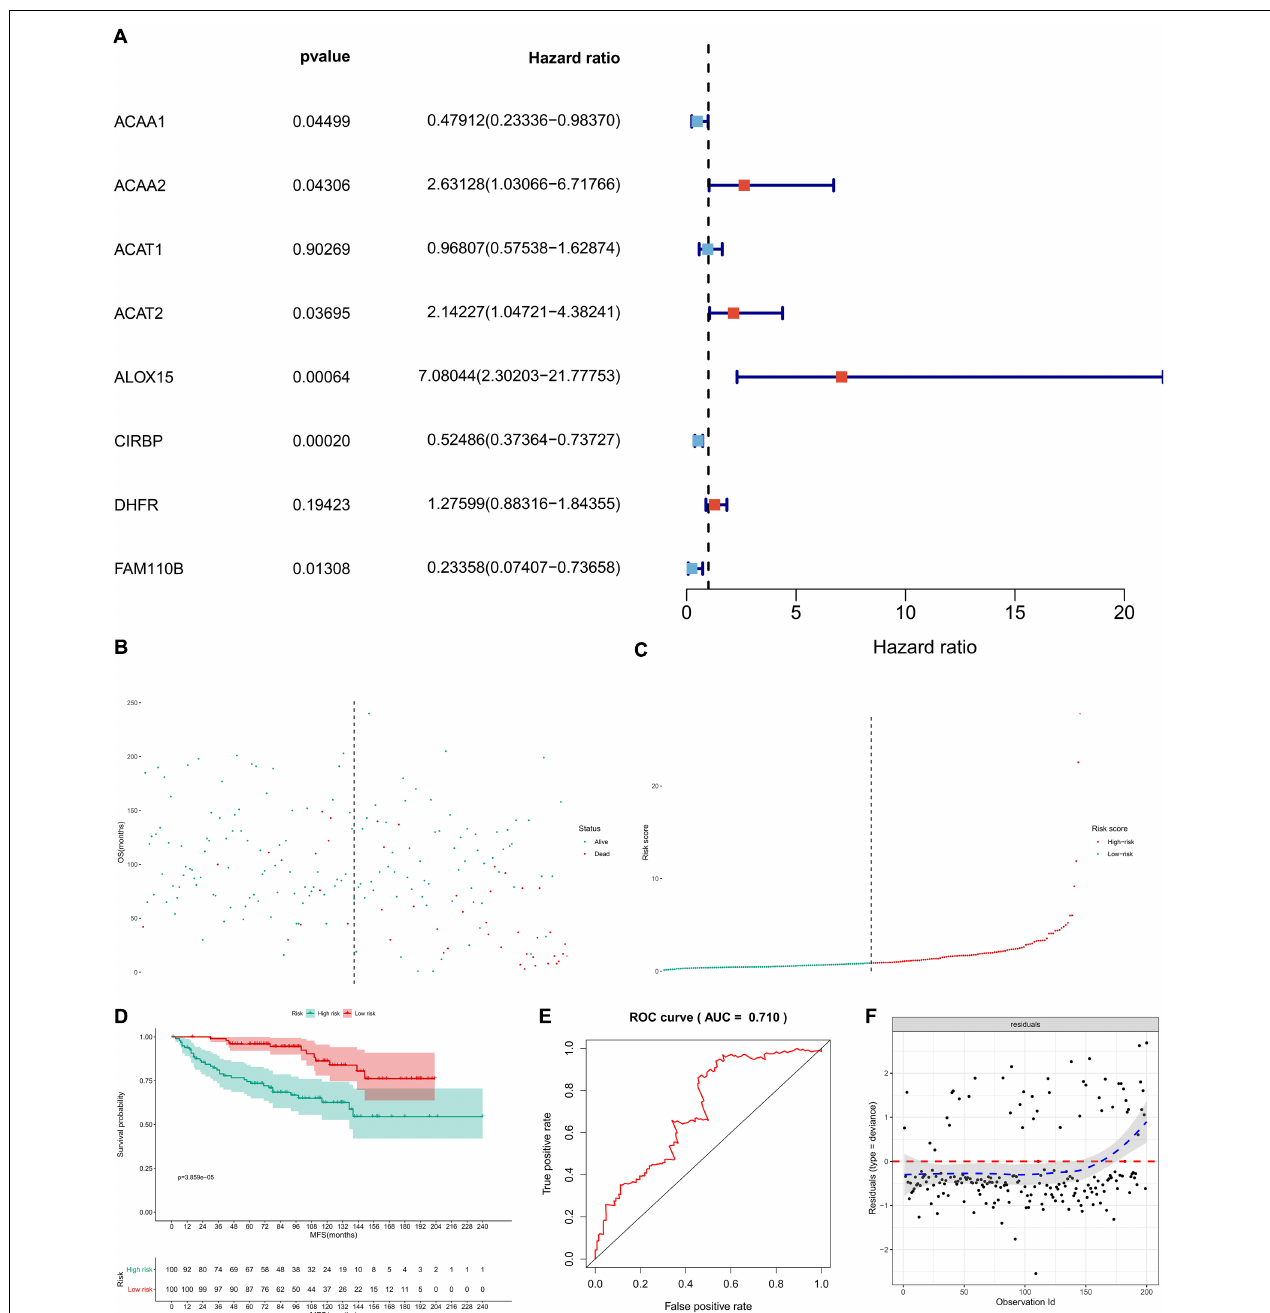
FIGURE 8 | Independent dataset validation by GSE11121. In GSE11121, univariate Cox regression analysis suggested that CIRBP ( P < 0.001), FAM110B ( P = 0.013), ACAA1 ( P = 0.045), ACAA2 ( P = 0.043), ACAT2 ( P = 0.037), and ALOX15 ( P < 0.001) had a significant association with metastasis-free survival (MFS) of BRCA patients (A) . Then, these key genes were incorporated into the multivariate Cox model, and the risk score for each BRCA patient was calculated by the formula of the multivariate model. The risk line and scatterplot illustrated the distribution of risk score among all patients (B,C) . The Kaplan–Meier survival